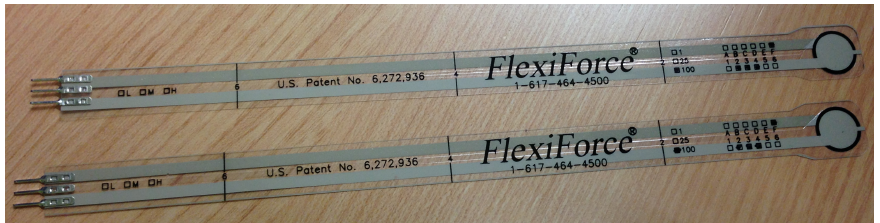
Figure 2. Flexiforce pressure sensor, 100 lbs.